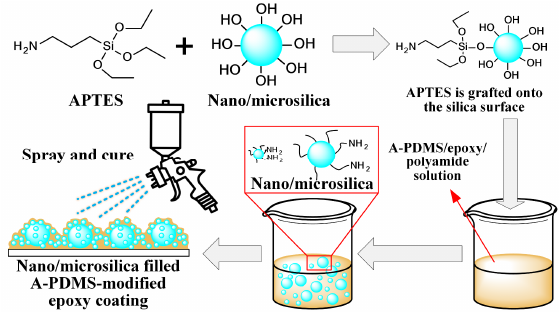
Figure 1. Reaction schemes of APTES-modified silica and the preparation procedure of the silica-filled A-PDMS-modified epoxy coating.